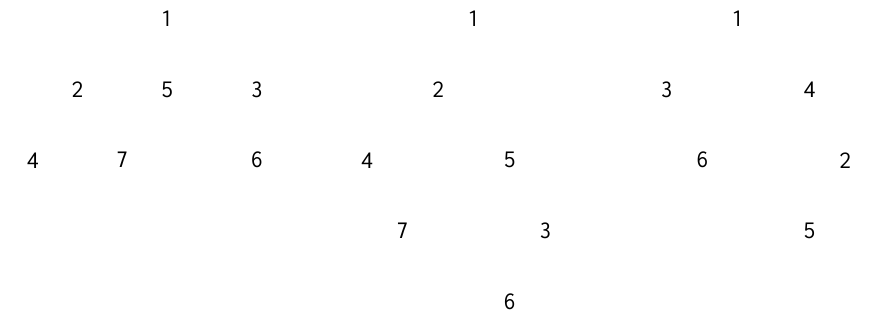
Fig. 3: A PORT of 7 nodes (left), its corresponding transformed binary tree (middle), and the binary tree obtained by removing the root and decreasing all label values by 1 (right).